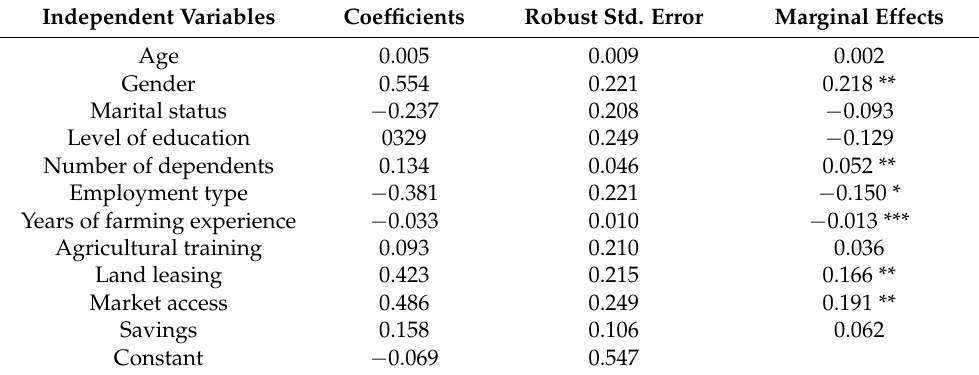
Table 3. Parameter estimates of the binary probit regression model’s analysis on livelihood diversification.